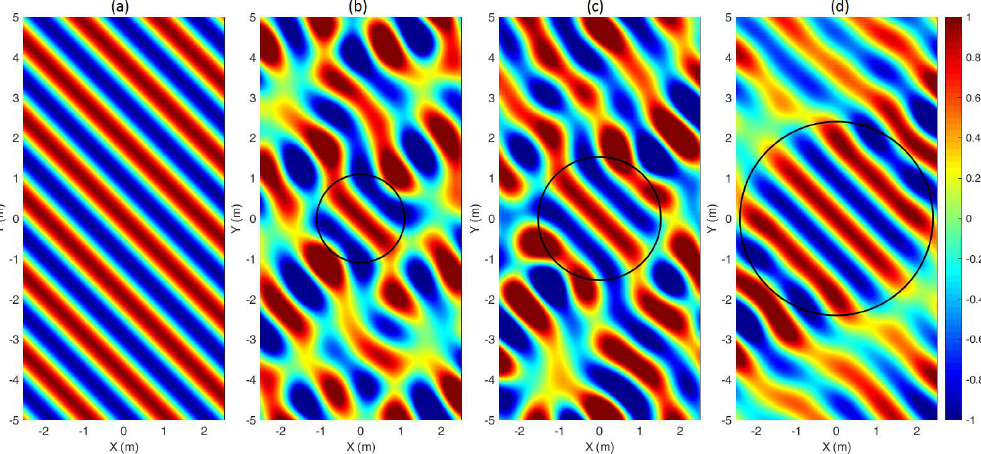
Figure 2. Reconstructed acoustic field using different numbers of plane waves in the expansion. ( a ) target field; ( b ) reconstructed field L = 36; ( c ) reconstructed field L = 64; ( d ) reconstructed field L = 144.